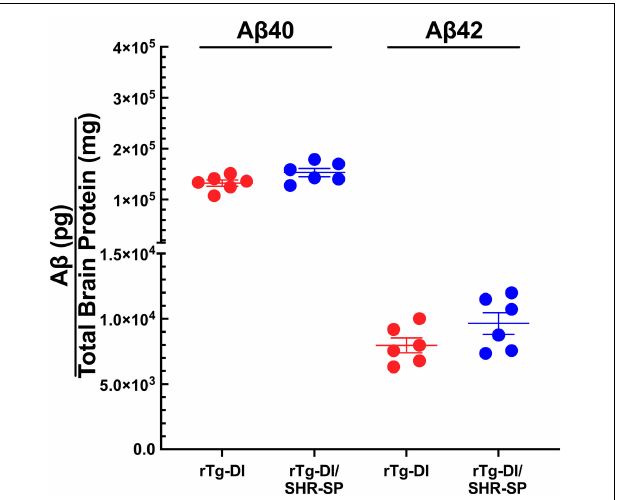
FIGURE 3 | Equivalent A β levels in 7 M rTg-DI and bigenic rTg-DI/SHR-SP rats. The levels of total A β 40 and A β 42 peptides in the forebrains of rTg-DI rats (red circles) and bigenic rTg-DI/SHR-SP rats (blue circles) were measured by ELISA as described under section “Materials and Methods.” The data presented are the means ± S.D. of n = 7 rats per group. Unpaired t -test showed that there are no significant differences between A β 40 and A β 42 levels in rTg-DI and bigenic rTg-DI/SHR-SP